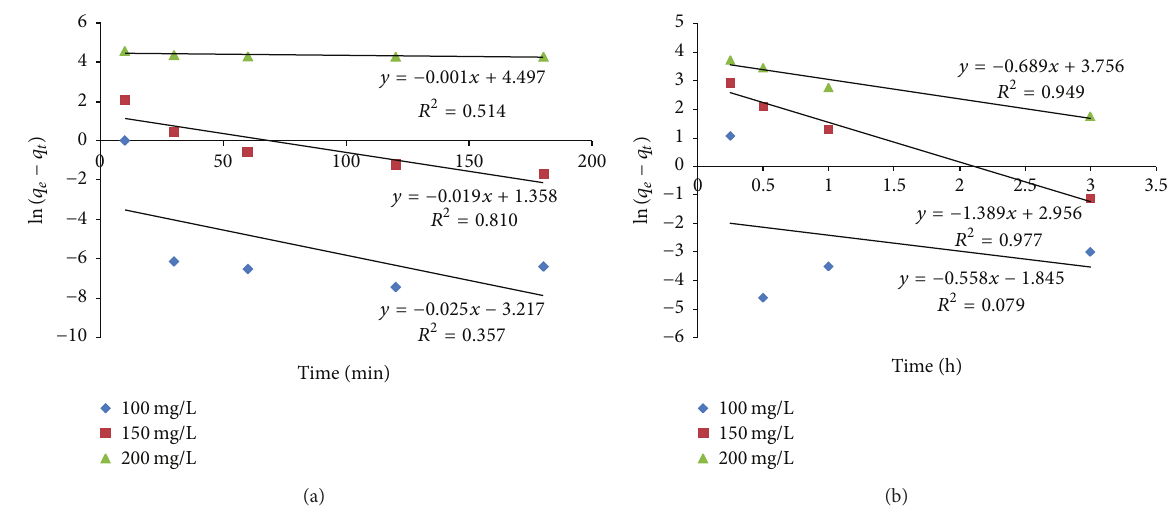
Figure 8: Plots of ln (𝑞 𝑒 − 𝑞 𝑡 ) versus time 𝑡 for different MB concentrations on OMCs-S (a) and OMCs-H (b).